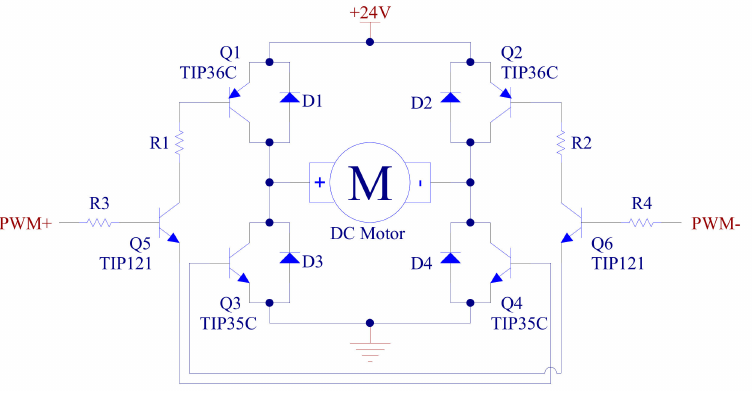
Figure 6. H-bridge driver circuit.